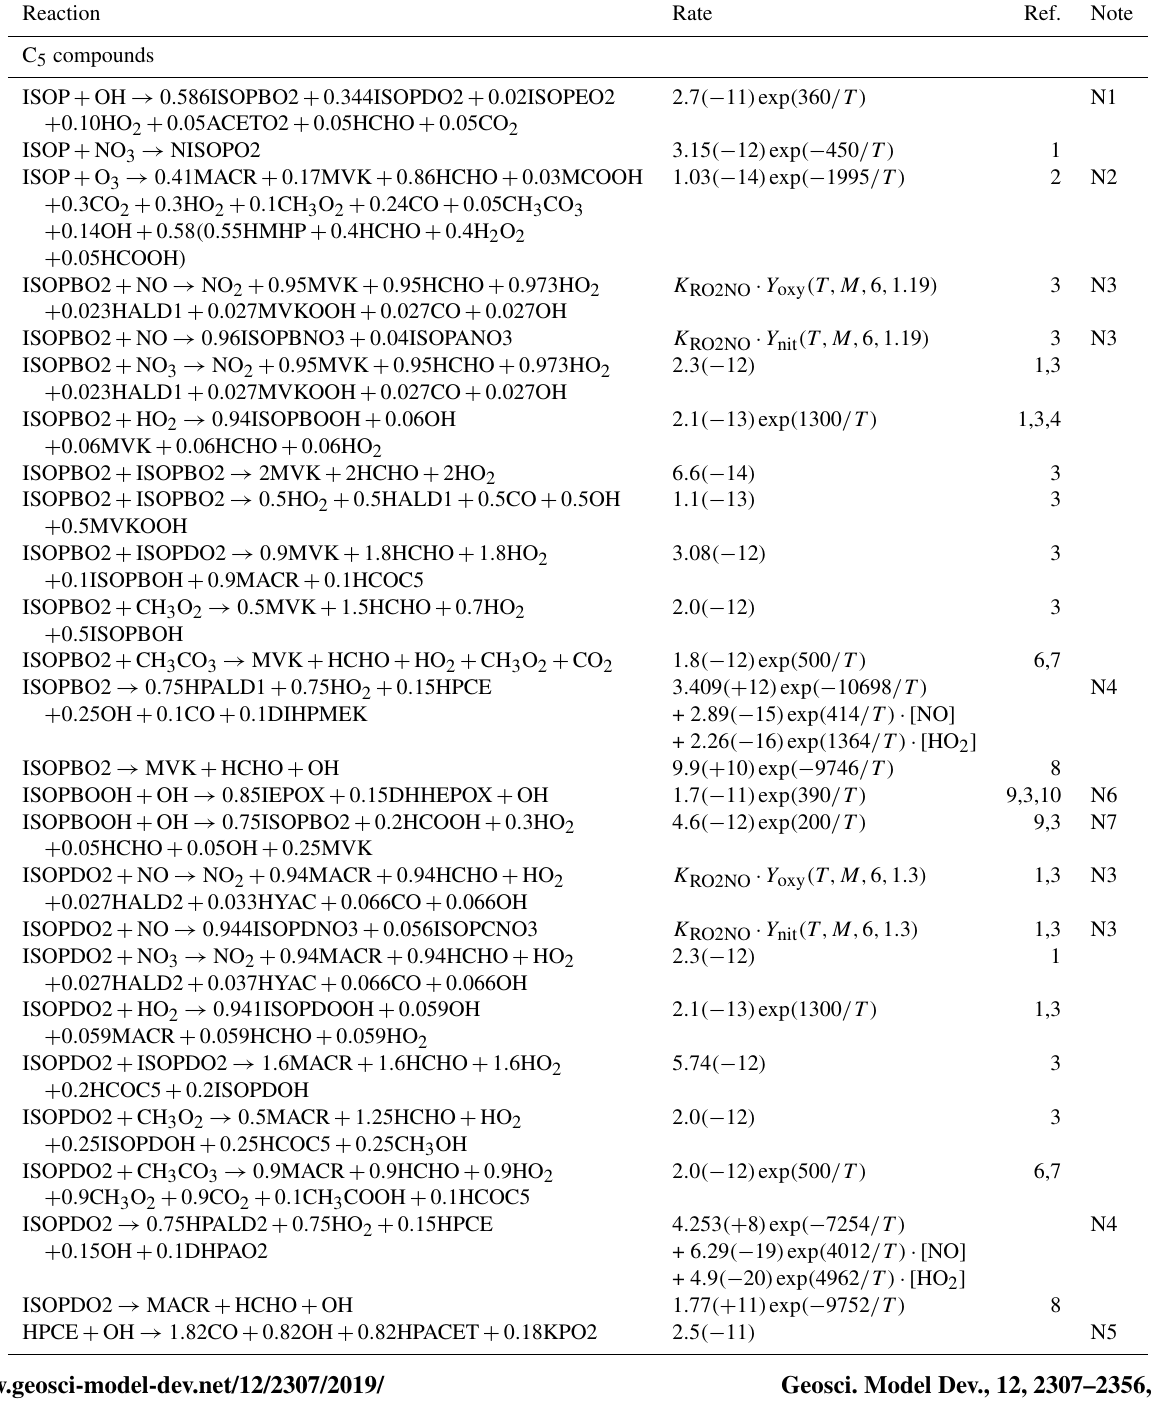
Table 2. Chemical mechanism and rates. Units for first-, second-, and third-order reactions are s − 1 , cm 3 molec. − 1 s − 1 , and cm 6 molec. − 2 s − 1 , respectively. Read 2 . 7 ( − 11 ) as 2 . 7 × 10 − 11 . T is temperature (K); [ M ] is air density (molec.cm − 3 ); K RO2NO = 2 . 7 ( − 12 ) exp ( 350 /T ) ; and the PAN-like compounds formation and decomposition rates are calculated with k =